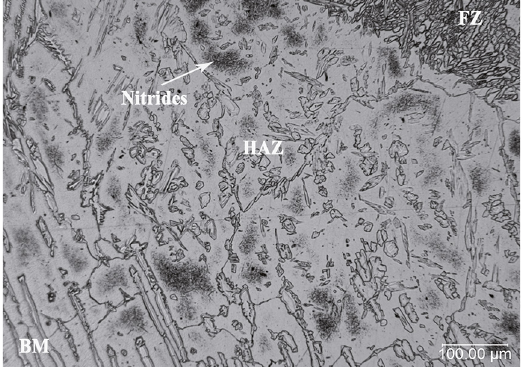
Figure 2: OM micrograph of nitride colonies in the interior of a ferrite grain in the HAZ of UNS S32304 (FCAW top of weld joint with 2209 as filler metal)